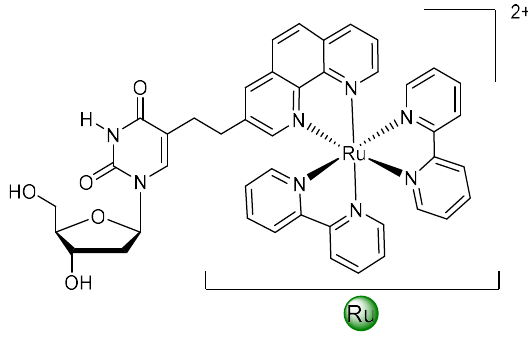
Figure 6. Structure of the Ru-containing-Uridine. Table 4. Showing the position of the osmium acceptor, [Os(bpy) 2 (3-ethynyl-1,10-phenanthroline)] 2+ , in various 19-mer duplexes where the ruthenium donor position, 1, remains the same (U-19) [92].